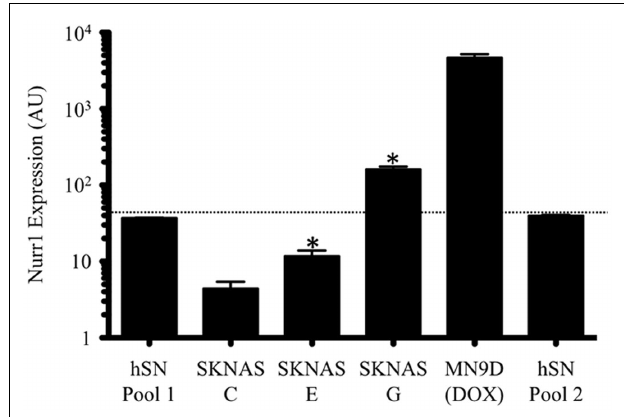
FIGURE 1 | Generation of neural cell lines with graded expression of the transcription factor NURR1. NURR1 gene expression in SK-N-AS-derived clonal lines E and G bracketed that seen in human substantia nigra, whereas acute NURR1 induction in the MN9D cell model was several orders of magnitude higher than seen in human tissue. Bars are the means ( ± SD) of biological triplicates (C, E, G cells) or single samples (MN9D and human SN pools) measured by qRT-PCR in duplicate. The two human SN pools were comprised of 15 independent specimens each. Note that data are plotted on a log scale. ∗ Indicates significant difference in NURR1 expression compared to control (C cells; one-tailed t -test, p ≤